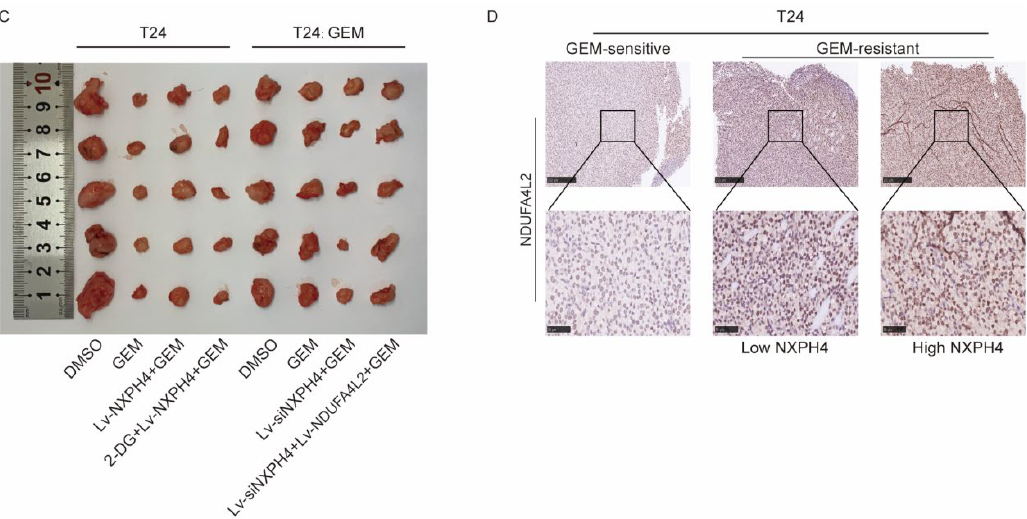
Figure 9. NXPH4/NDUFA4L2 pathway is essential for GEM resistance of BC cells in vivo. ( A – C ) Subcutaneous implantation mouse models were established using parental or GEM-R BC cells transfected with lentivirus containing NXPH4 plasmid and siNXPH4 and/or NDUFA4L2 plasmid. Growth curve ( A ), representative images ( B ), and tumor weight ( C ) of xenografts ( n = 5) in the eight treatment groups for 36 days are shown. ( D ) IHC staining of NDUFA4L2 was performed in the tumor sections from mouse models that were established using parental or GEM-R BC cells transfected with lentivirus containing NXPH4 plasmid and siNXPH4. * p < 0.05; ** p < 0.01; *** p < 0.001. N.S.